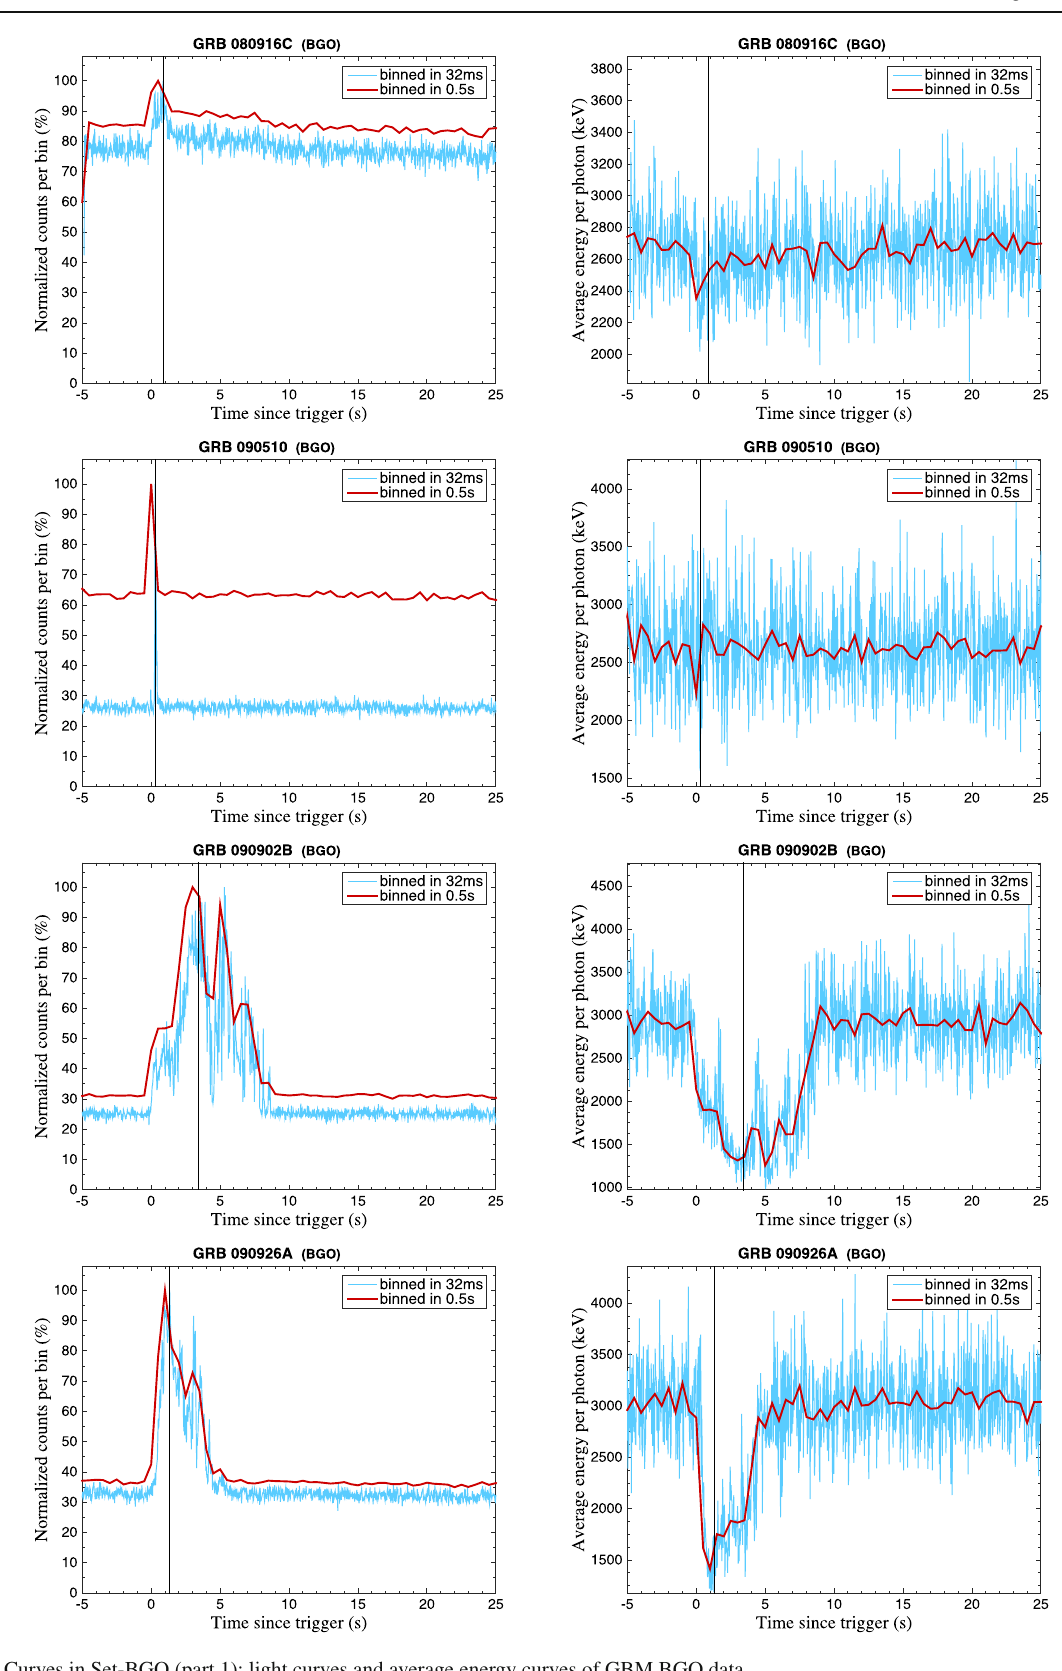
Fig. 19 Curves in Set-BGO (part 1): light curves and average energy curves of GBM BGO